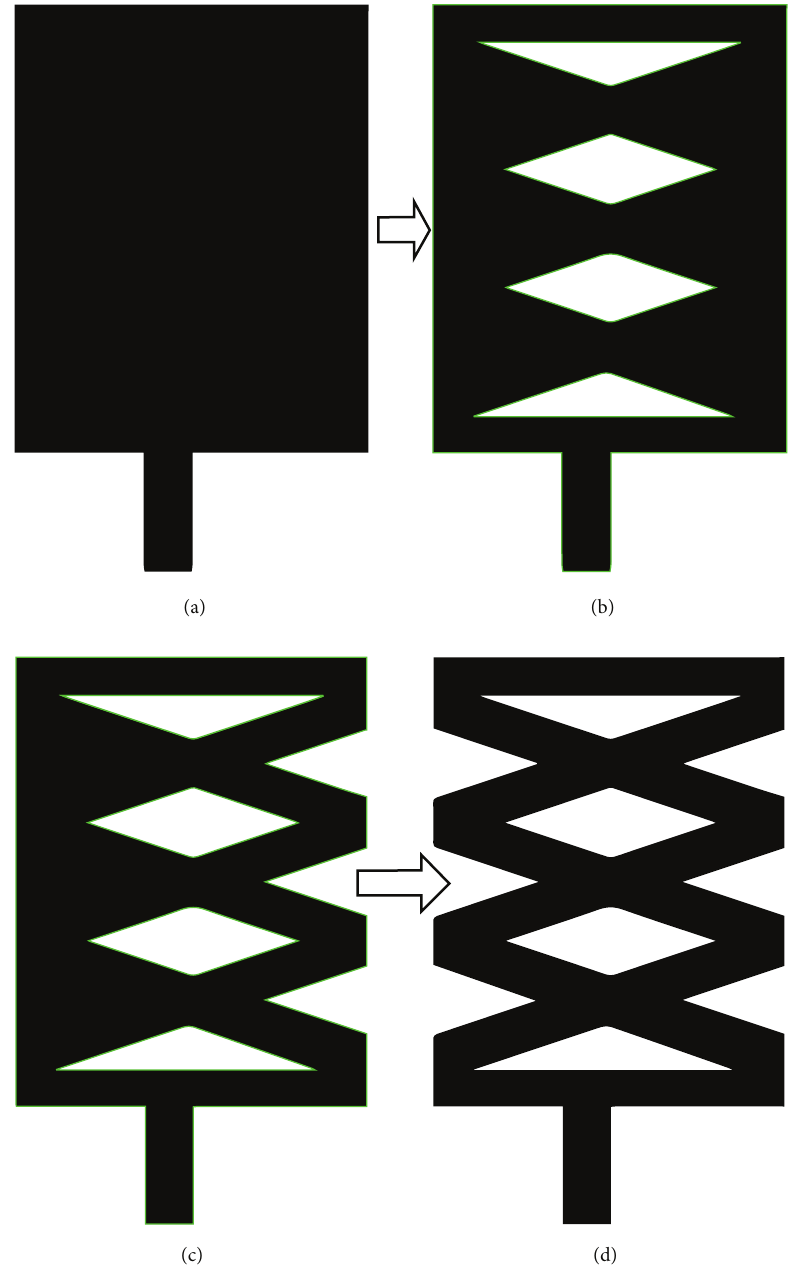
Figure 4: Antenna evaluation: (a) antenna 1, (b) antenna 2, (c) antenna 3, and (d) proposed antenna